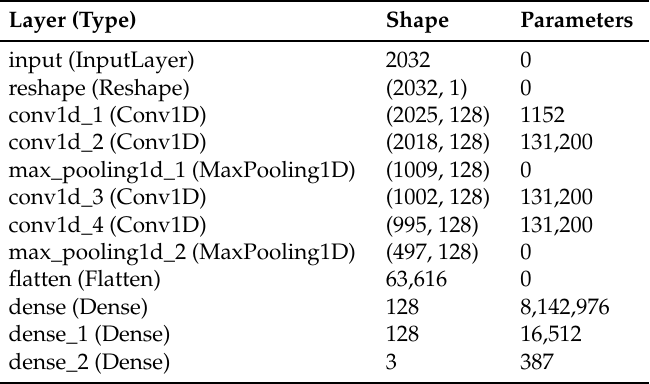
Table 2. Neural network layer configuration information of the CNN used in the